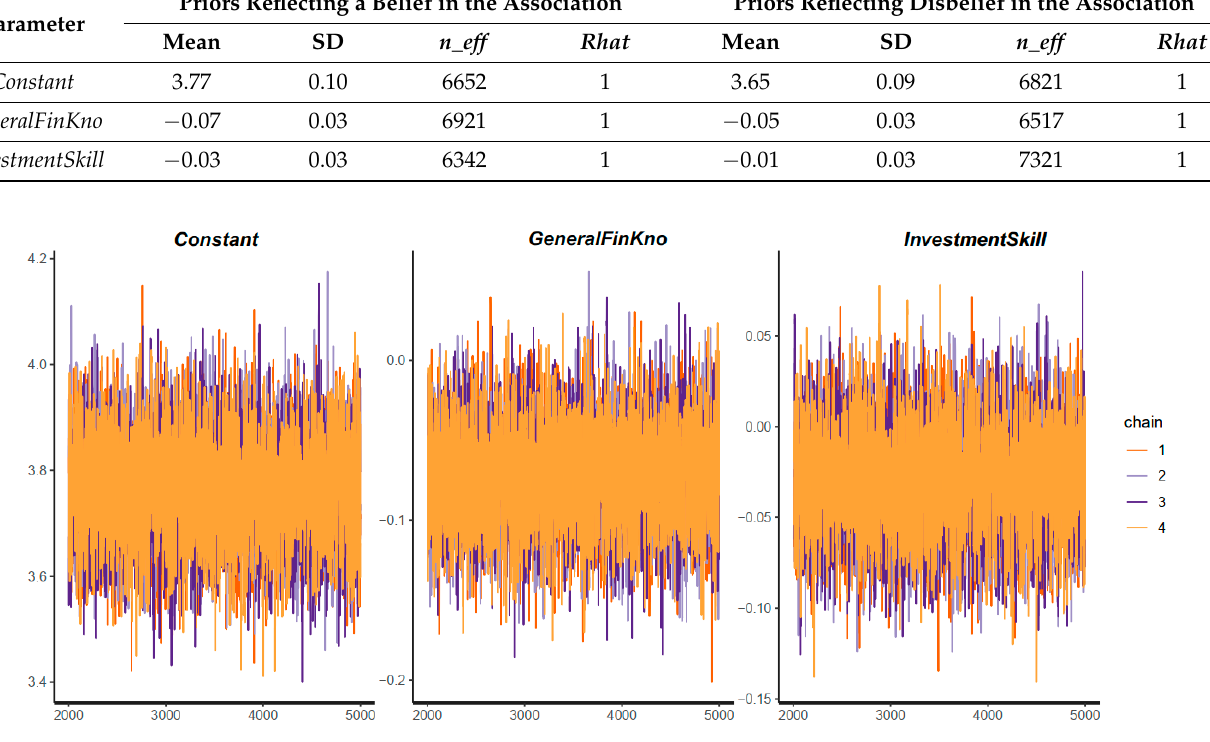
Figure 2. Model 1 ′ s trace plots. Figure 2. Model 1’s trace